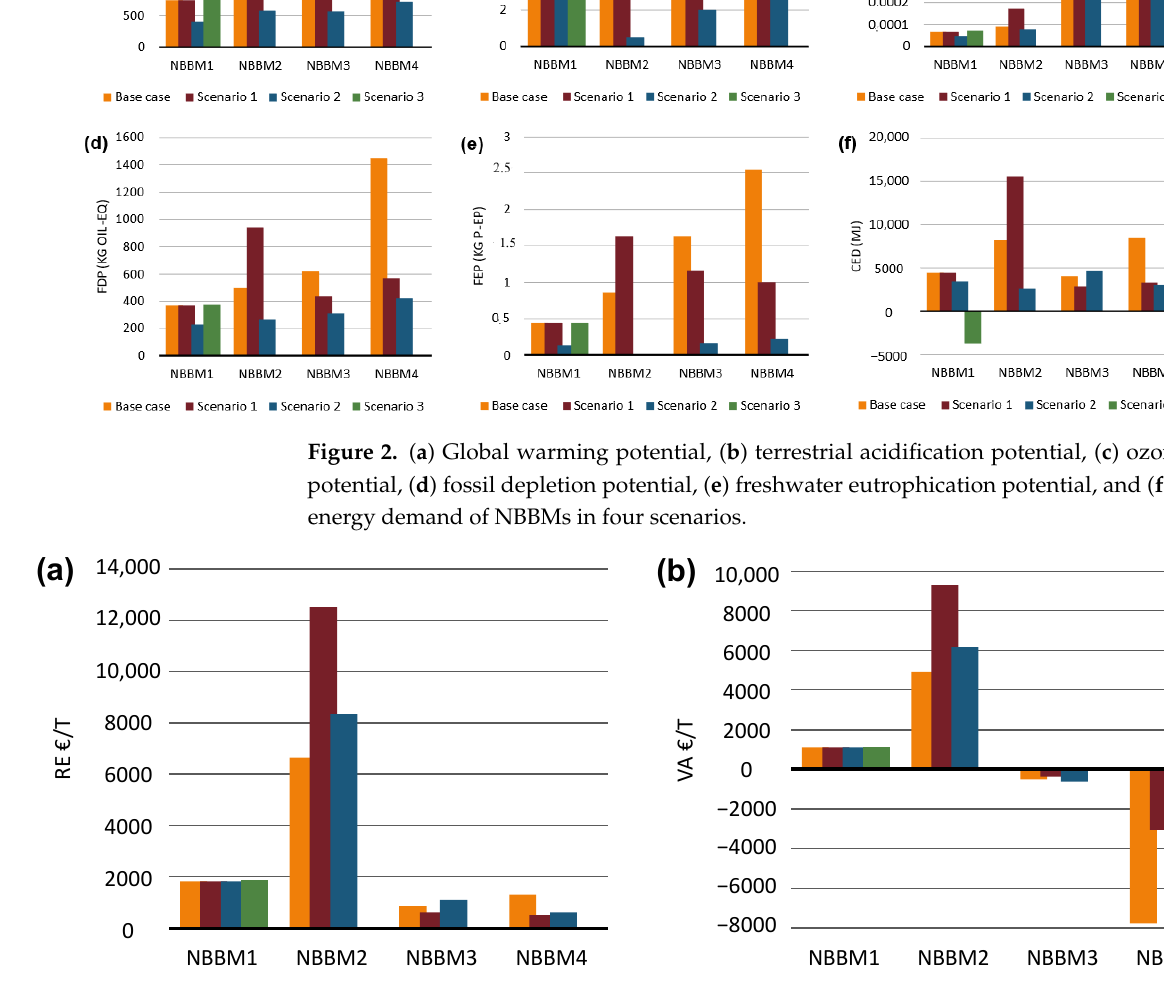
Table 7. Ranking of eco-efficiency (revenue) performance of the different scenarios in the different impact categories (green = best to red = worst).